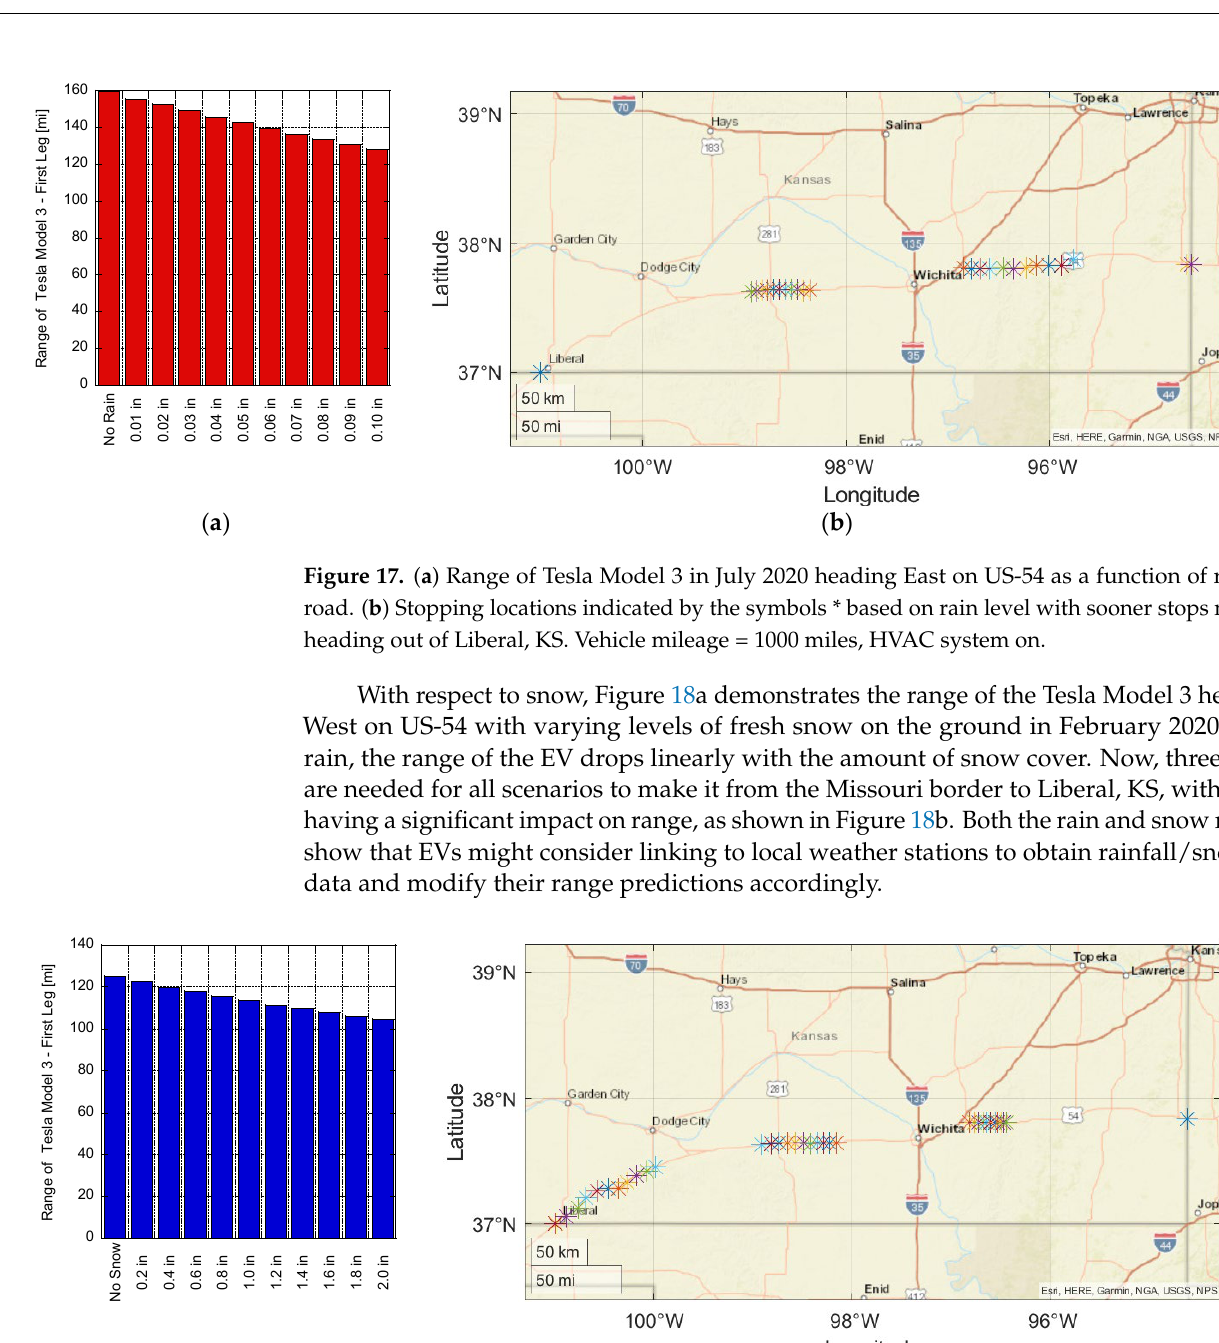
Figure 18. ( a ) Range of Tesla Model 3 in February 2020 heading West on US-54 as a function of snow on road. ( b ) Stopping locations indicated by the symbols * based on snow level with sooner stops needed heading from the Missouri border. Vehicle mileage = 1000 miles, HVAC system on.